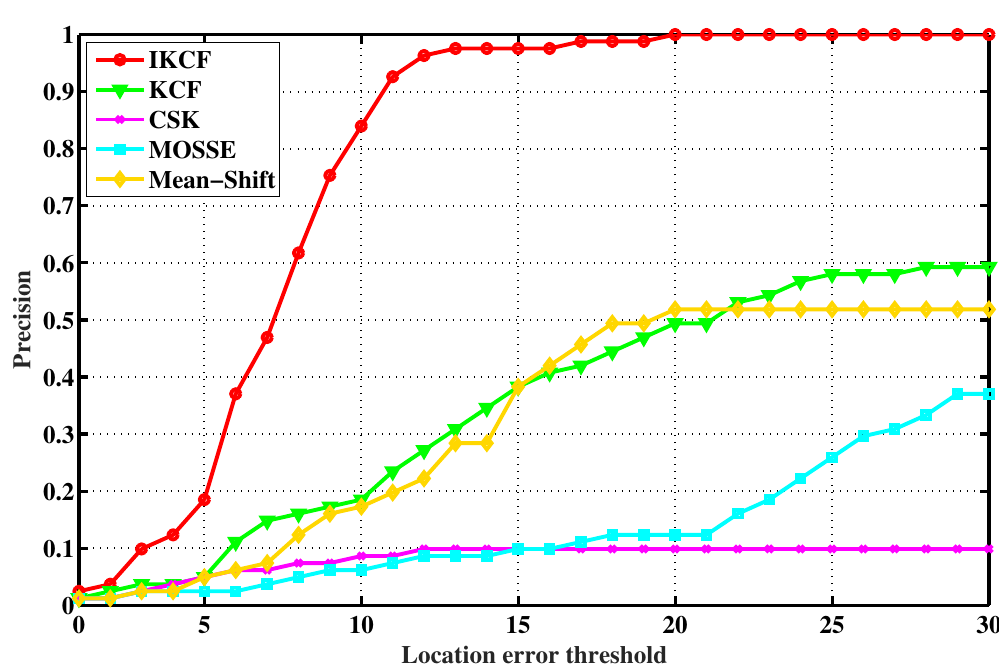
Figure 14. Location error precision curves (354th frame to 434th